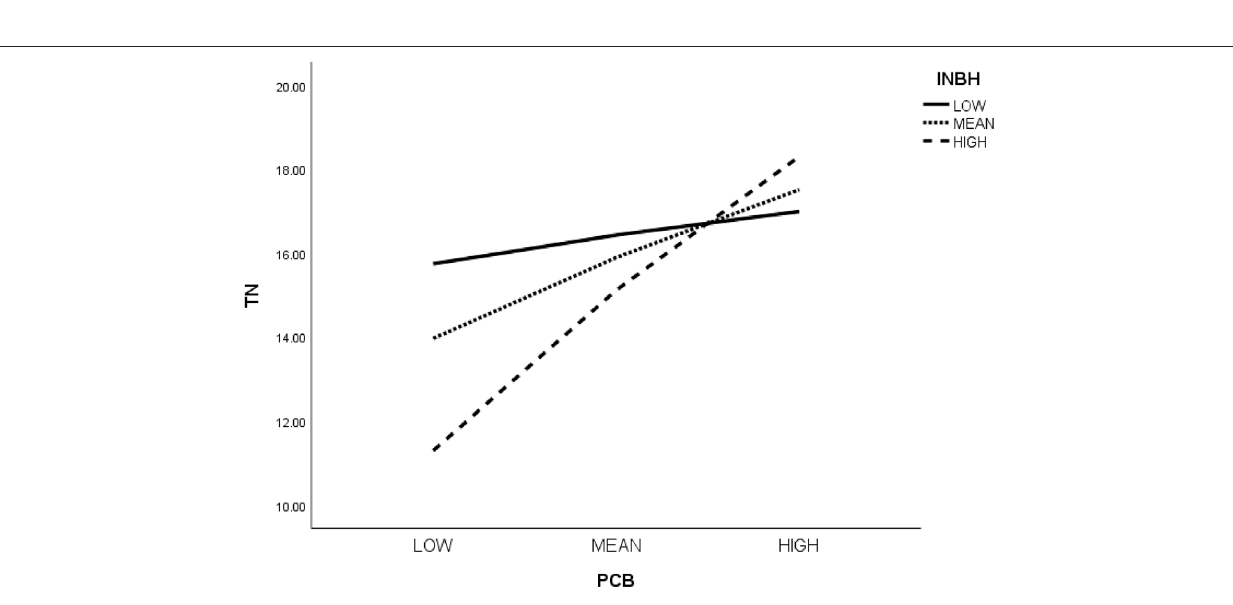
FIGURE 5 | The moderating role of organizational climate (intimate behaviour) in the psychological contract breach and turnover intentions relations.